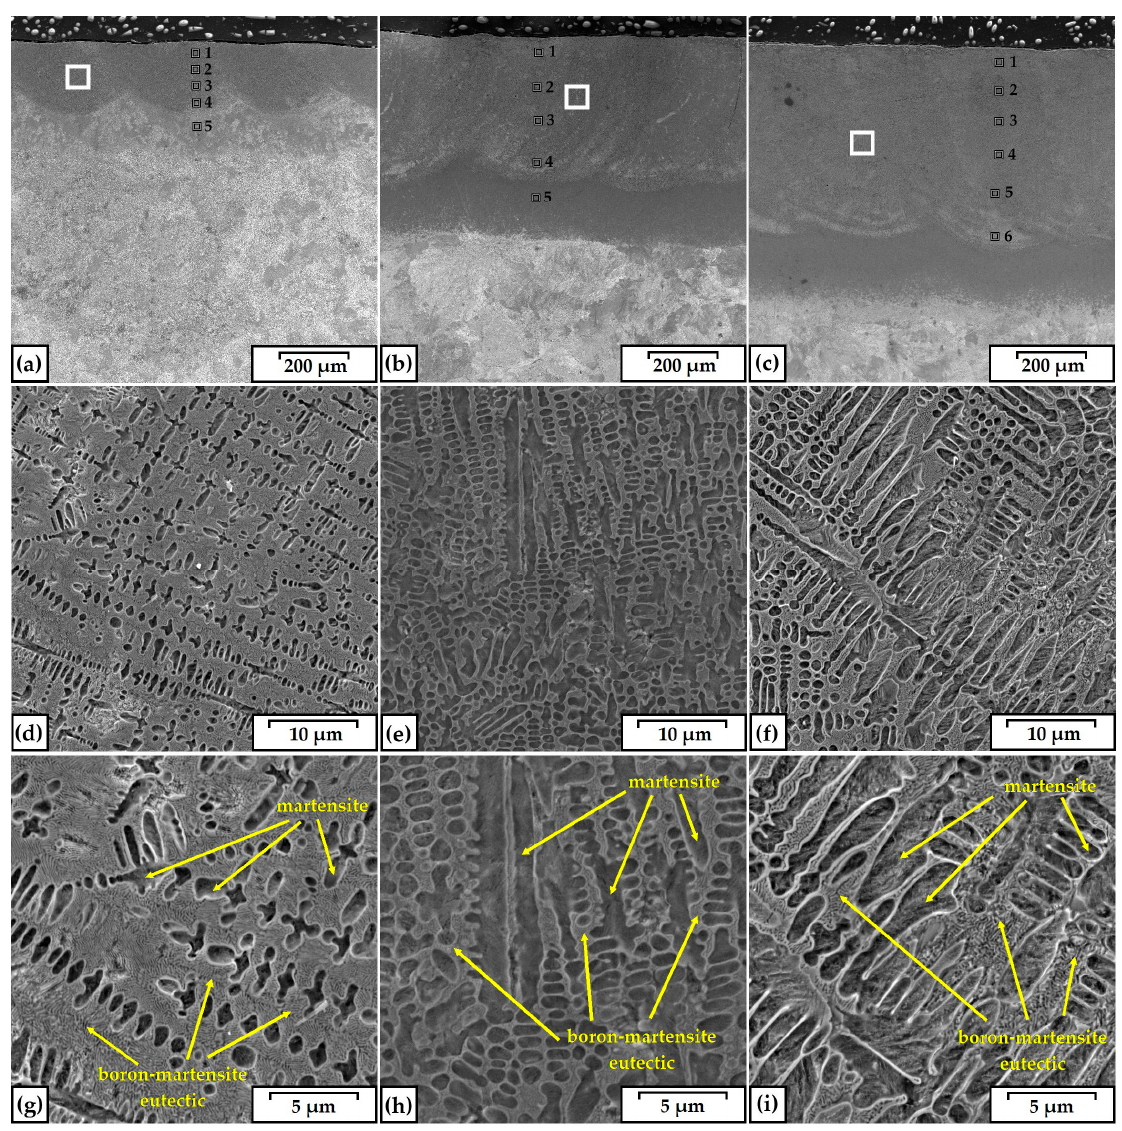
Figure 3. Microstructure of FeB-Fe 2 B-Fe 3 (B,C) produced using laser beam power density: 76 kW/cm 2 ( a , d , g ); 115 kW/cm 2 ( b , e , h ); 153 kW/cm 2 ( c , f , i ).